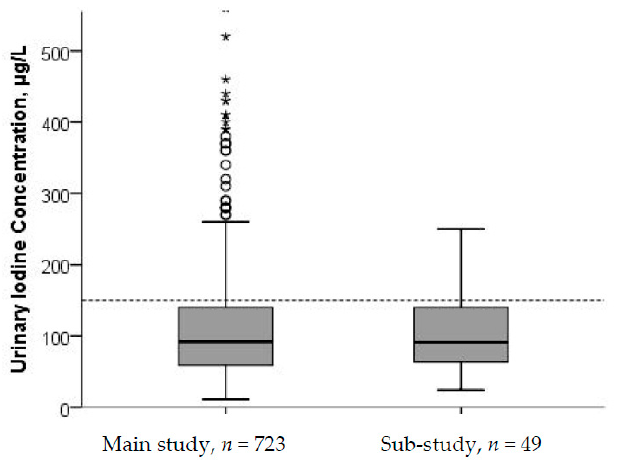
Figure 1. Urinary iodine concentration (UIC) from main study ( n = 723) and sub-study ( n = 49). Five cases with UIC > 500 µ g/L in the main study were excluded from the figure. The stippled horizontal line marks the epidemiological criteria for assessing adequate iodine nutrition based on median UIC by the WHO